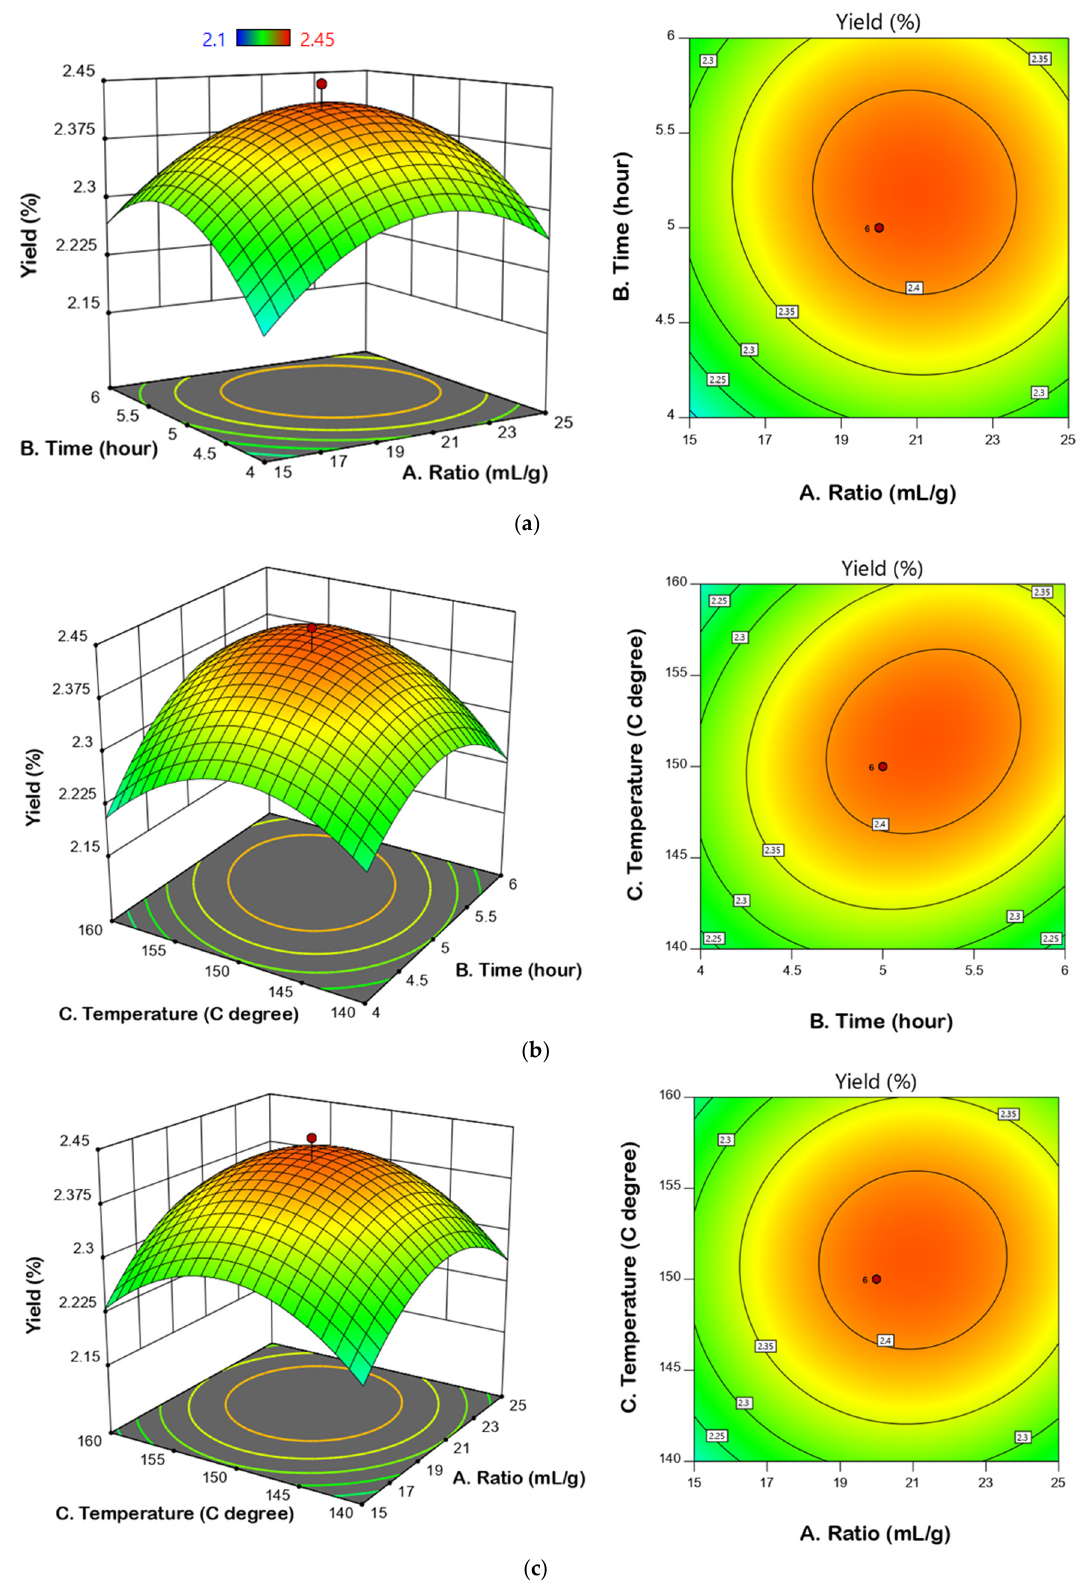
Figure 11. Surface and contour plots with respect to ( a ) time and ratio, ( b ) temperature and time, and ( c ) ratio and temperature. Table 3. Extraction yields at optimum conditions.